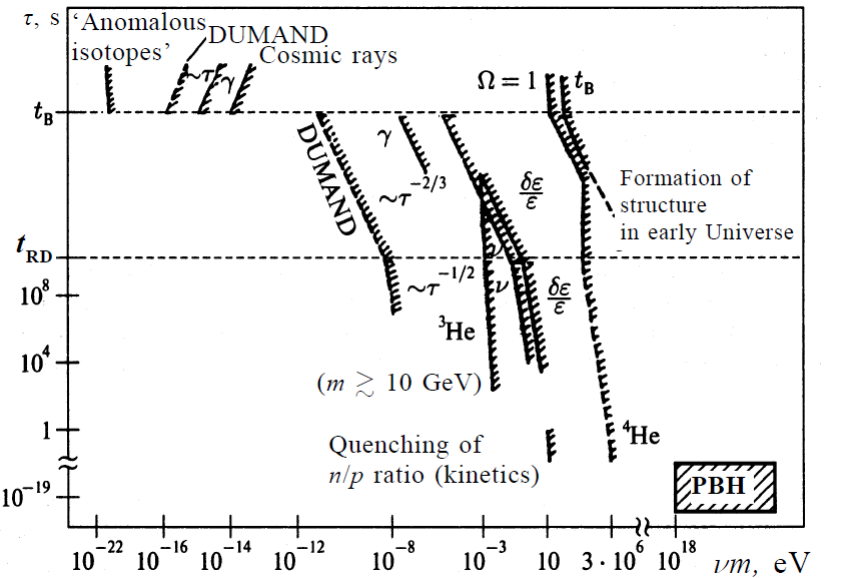
Figure 2. The constraints [9] on the possible effects of particles with relative concentration ν and mass m at the cosmological time τ